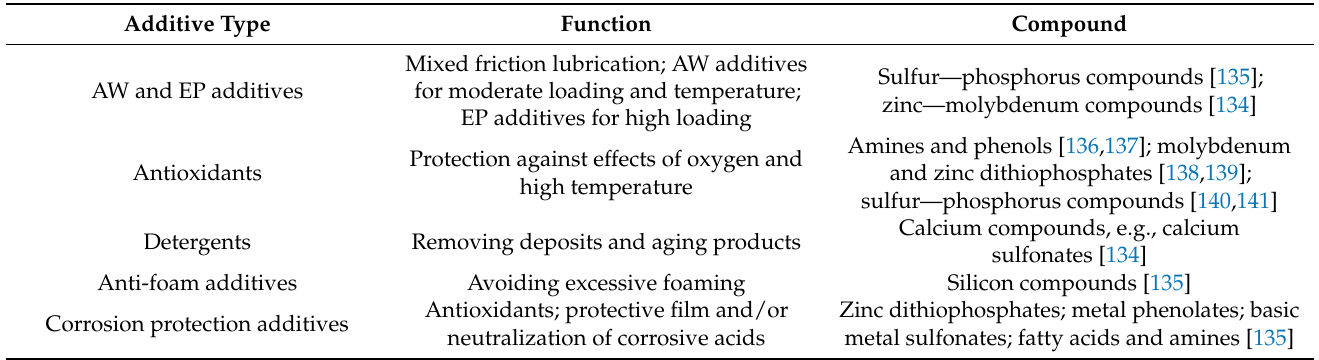
Table 2. Functions and compounds of some additives of gearbox